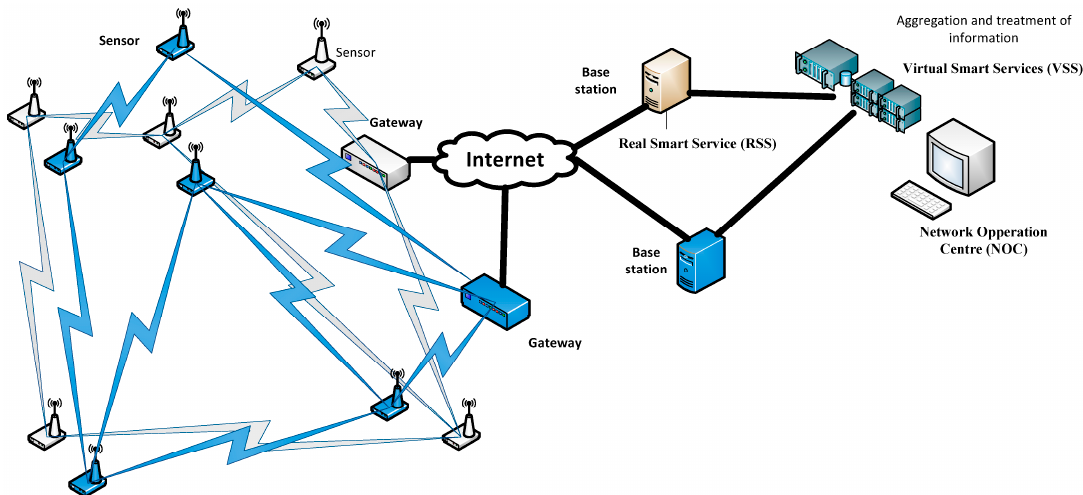
Figure 5. Joint service in the city as the superposition of individual services.